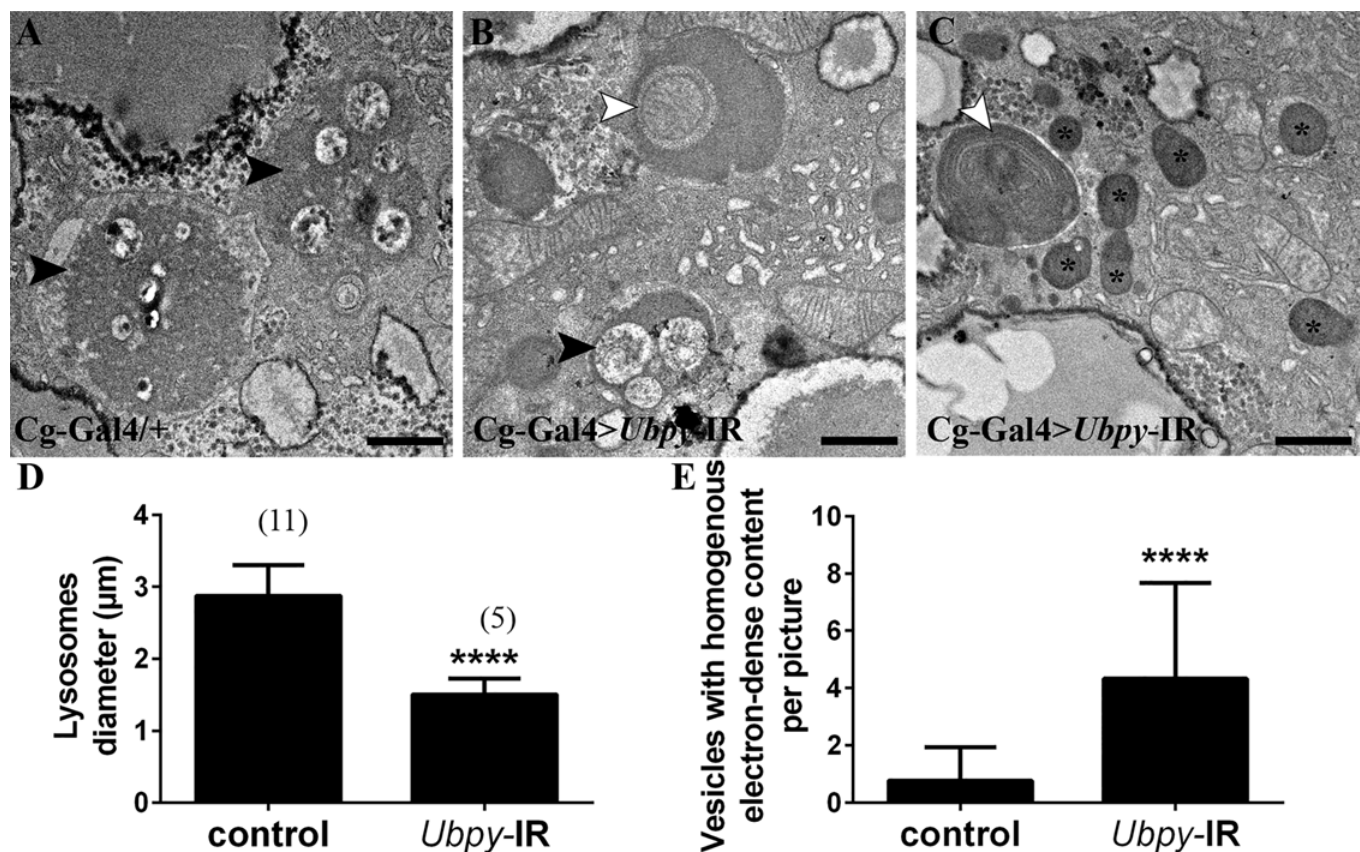
Fig 4. Ultrastructural analysis of Ubpy silenced cells. Control fat body cells (A) contain large autolysosomes (black arrowhead). These vesicles are characterized by their heterogeneous content and organelle remnants. In contrast, Ubpy silenced cells (B-C) contain autophagosomes whith non-degraded organelles (white arrowhead) (a mitochondria in B and endoplasmic reticulum in C), small autolysosomes (black arrowhead) and vesicles with homogenous electron-dense content (asterisks). Scale bars: 1 μ m. (D-E) Quantification of lysosomal diameter (D) and number of vesicles with homogenous electron-dense content (E). Bars denote mean ± s.d. Statistical significance was determined using t-test : **** p < 0.0001. Genotypes: (A) Cg-Ggal4/+ , (B-C) Cg-Gal4/+; UAS-Ubpy-IR/+ .